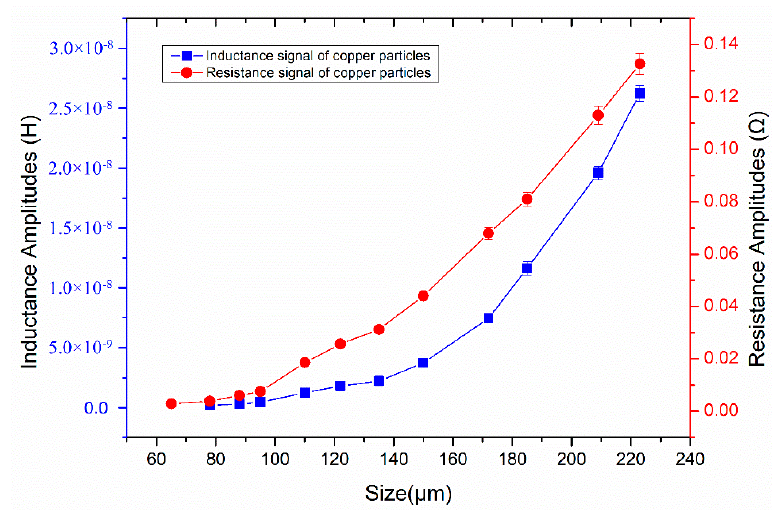
Figure 7. The relationship between average pulse amplitude and particle size.